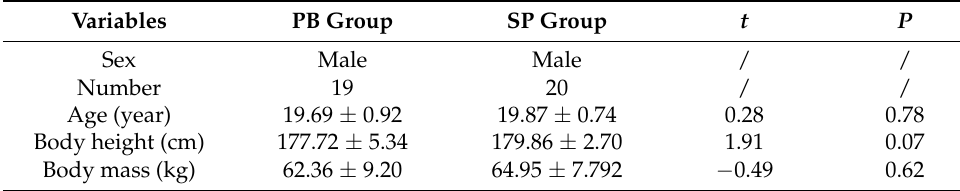
Table 1. The characteristics of the participants in baseline. Variables PB Group